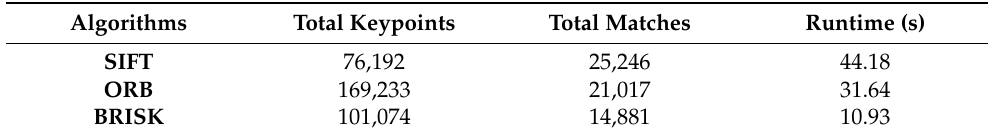
Table 3. The sum results obtained from pairs of images after applying the three algorithms to datasets, which contain sequences of images for the same